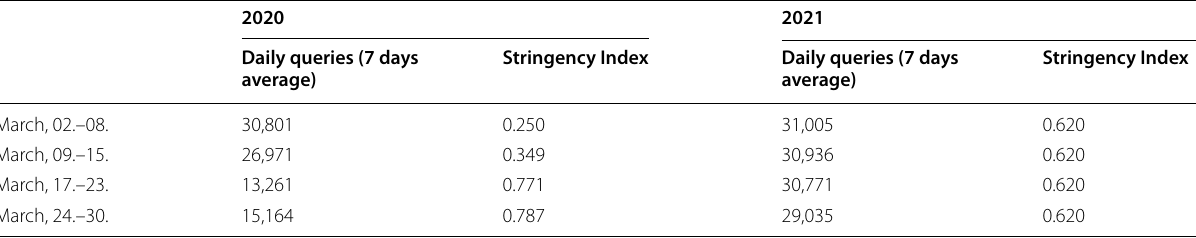
Averages of daily queries in week 2 and week 1 before and after the date of the first shutdown, March 16th, 2020. The Stringency Index is a measure for restrictiveness of politically imposed countermeasures, which is described later in this